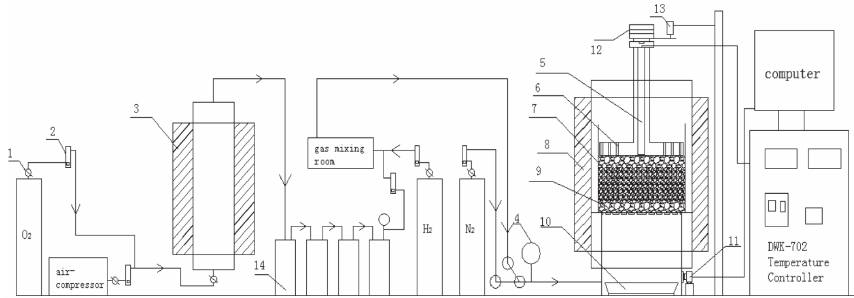
Figure 1: Structure of experimental